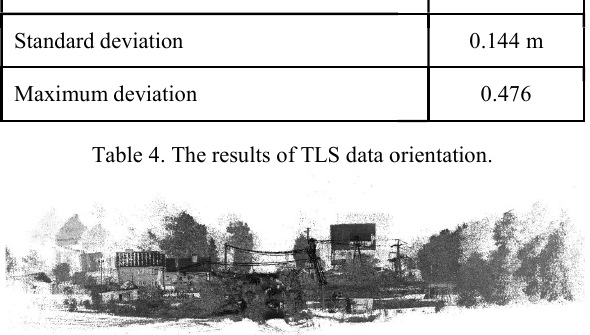
Figure 4 . Isometric view of oriented TLS point clouds: view of the intensity of the laser